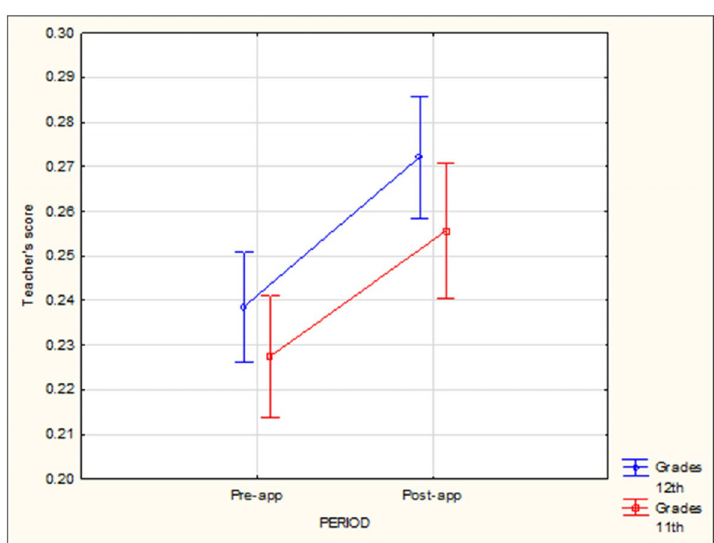
Fig. 3 Multifactorial dispersive analysis of the index Teacher’s Score (factors: grades, period)